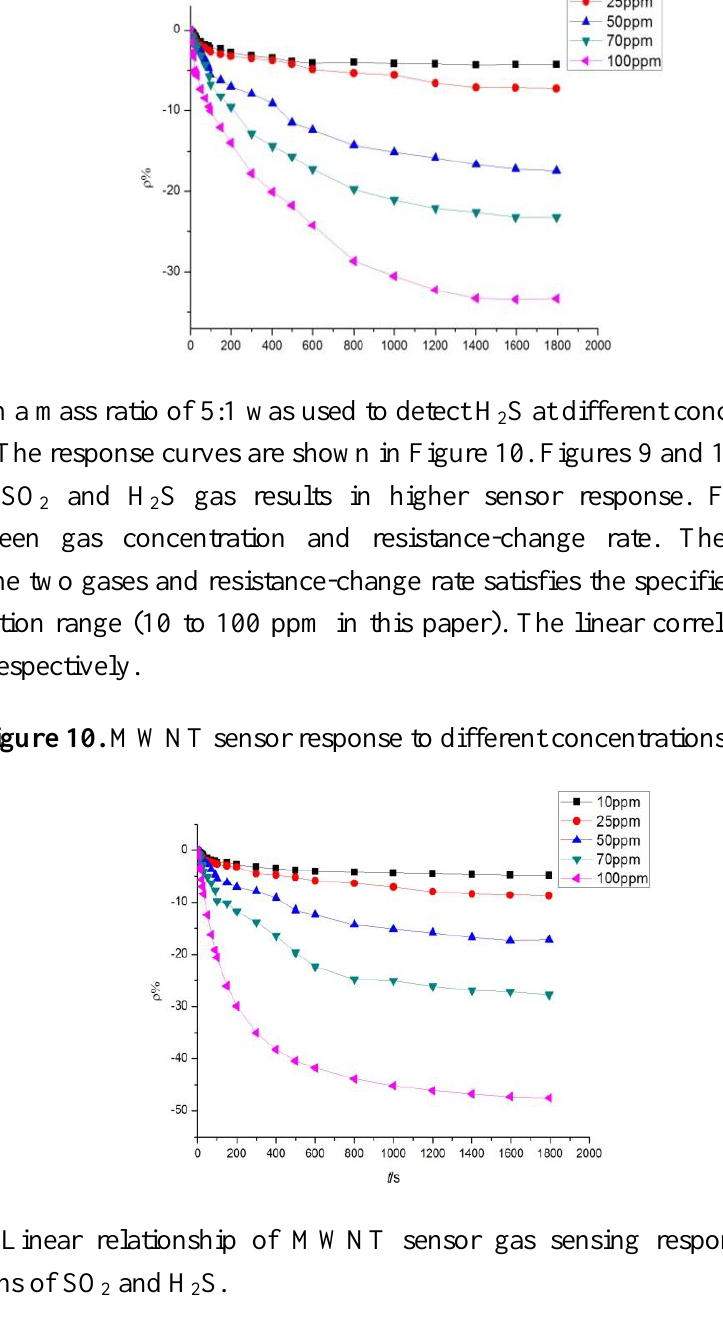
Figure 9. MWNT sensor response to different concentrations of SO